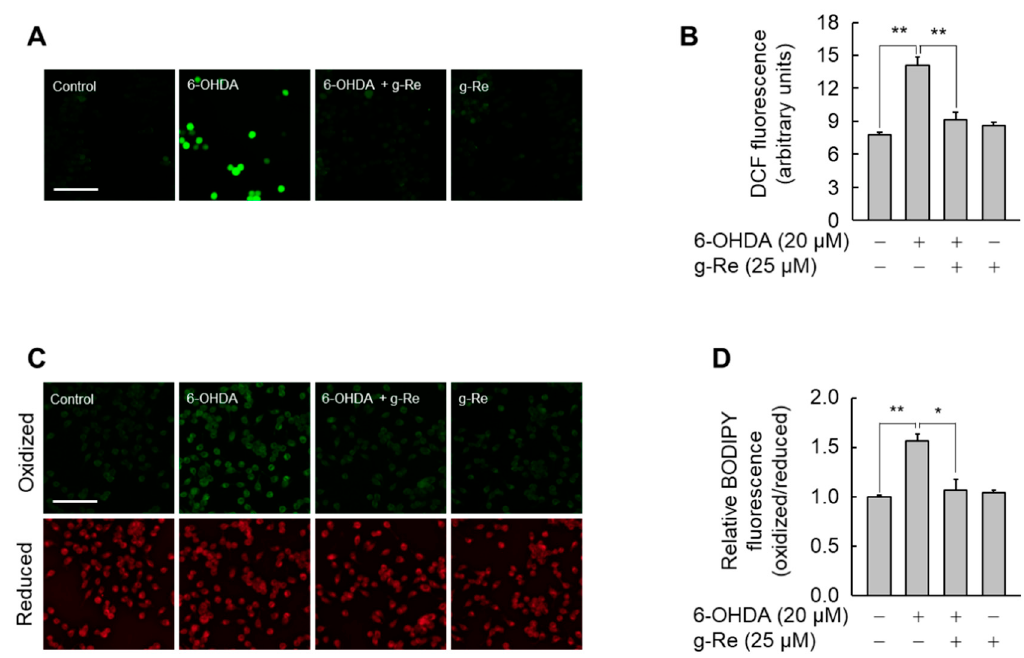
Figure 6. Effect of ginsenoside Re (g-Re) on 6-OHDA-induced reactive oxygen species (ROS) production and lipid peroxidation. SH-SY5Y cells pretreated with g-Re for 9 h were incubated with or without 6-OHDA. ( A , B ) Following incubation for 24 h, cells were further incubated in medium containing 50 µM 2 ′ ,7 ′ -Dichlorofluorescin diacetate (H2DCF-DA) for 30 min. The intracellular ROS level was determined by fluorescence microscopy ( A ), and the fluorescence intensities were quantified ( B ). ( C , D ) Lipid peroxidation was investigated in cells incubated with 1 µM C11-BODIPY for the final 30 min. Fluorescence of C11-BODIPY, which corresponded to the level of lipid peroxidation, was measured by fluorescence microscopy ( C ). The intensities of fluorescence ( B ) and oxidized/reduced C11-BODIPY ( D ) are presented as mean ± SE (n = 3). Scale bars = 100 µm. * p < 0.05, ** p < 0.01.